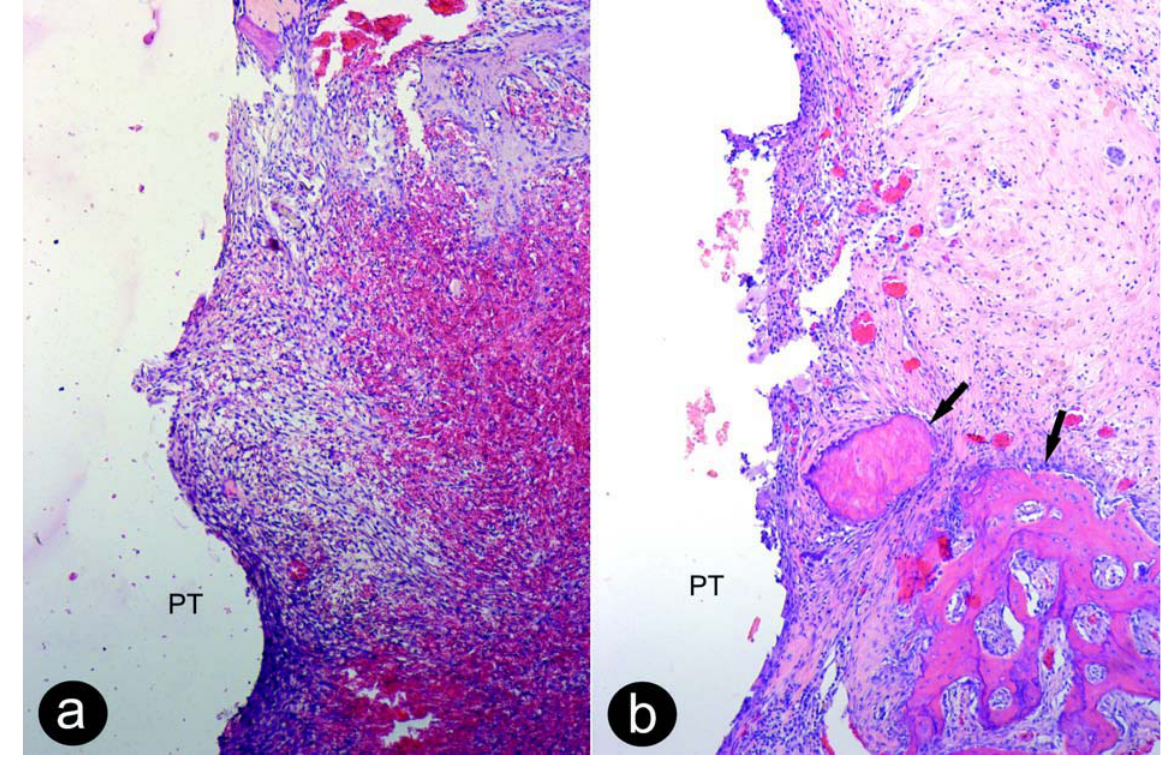
FIGURE 2- This image shows the behavior of Group I at 7 days (a) and 28 days (b) close to the polyethylene tubes (PT). The arrows indicate bone tissue formation. HE, original magnification